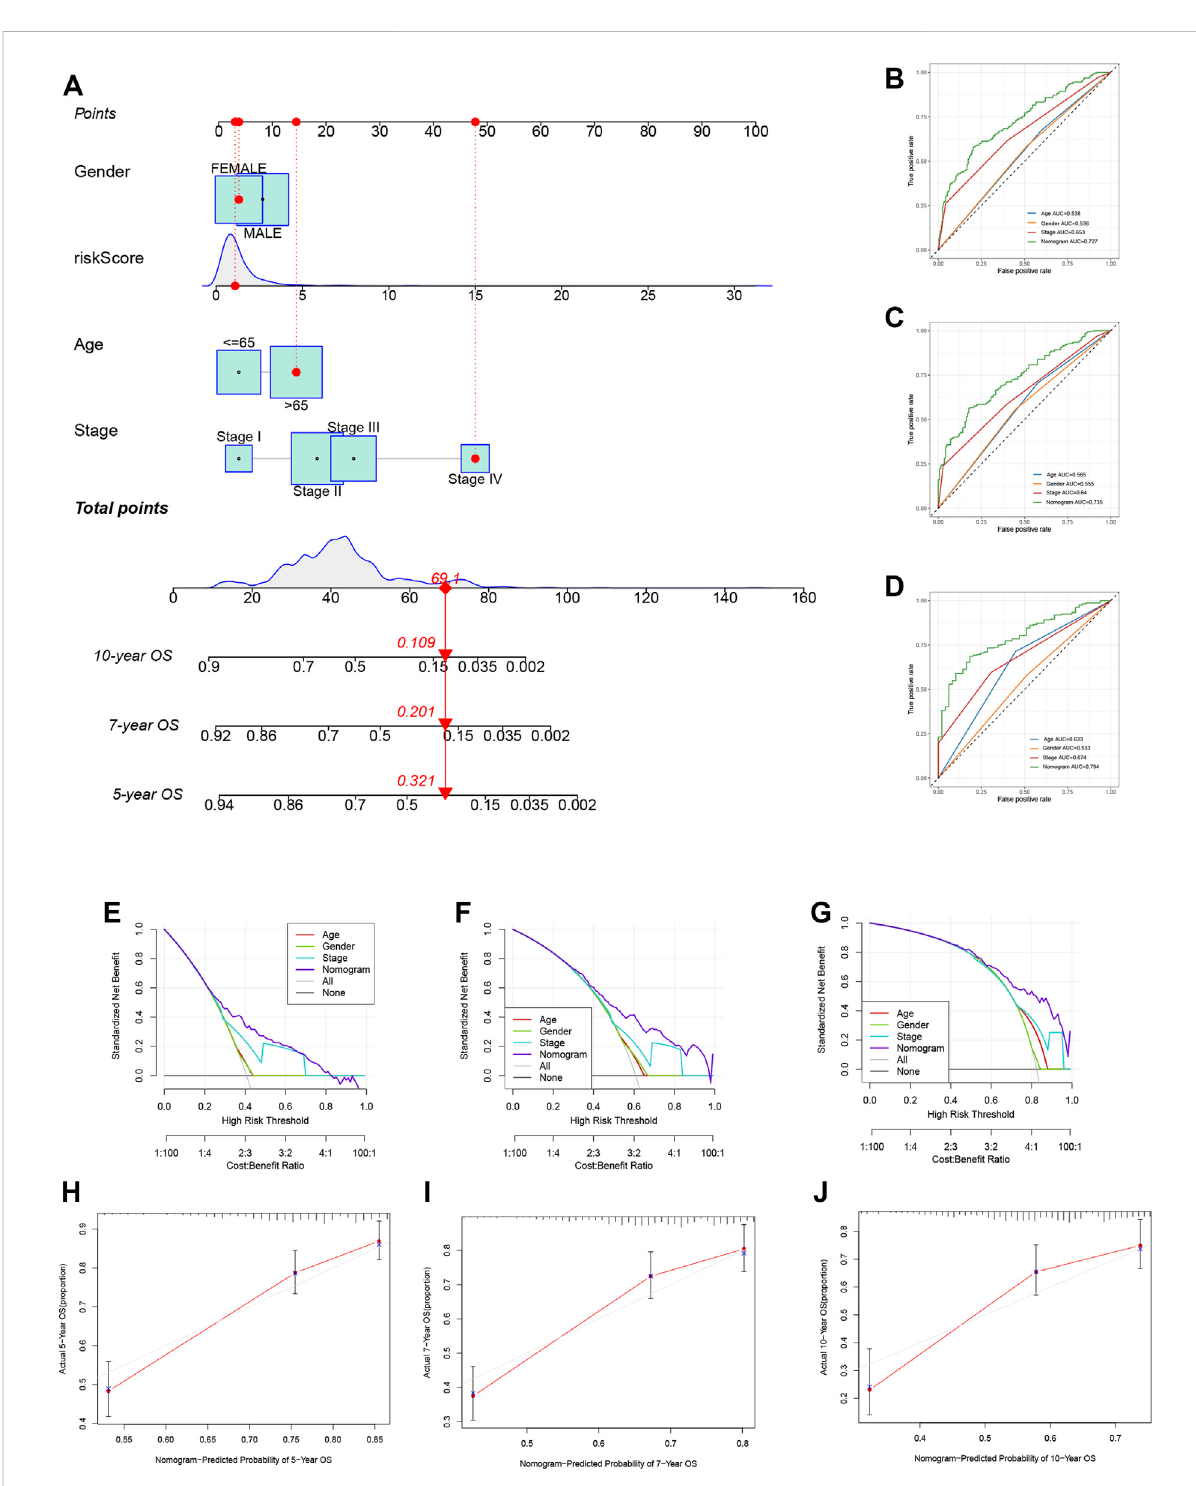
FIGURE 10 DevelopmentofanomogrambasedonTRMRGriskscoresignature. (A) NomogramintegratingTRMRGriskscore,age,genderandtumorstage for predicting 5, 7,10 yearsOS. (B – D) Time-dependentROC curvesevaluating theef fi cacy ofthetotalnomogramscore inpredicting (B) 5, (C) 7, (D) 10 years OS, in comparison to age, gender and tumor stage. (E – G) DCA curves estimating the ef fi cacy of the nomogram in predicting (E) 5, (F) 7, (G) 10 years OS from the perspective of clinical bene fi t. (H – J) Calibration curves of the nomogram for predicting (H) 5, (I) 7, (J) 10 years OS. AUC: area under